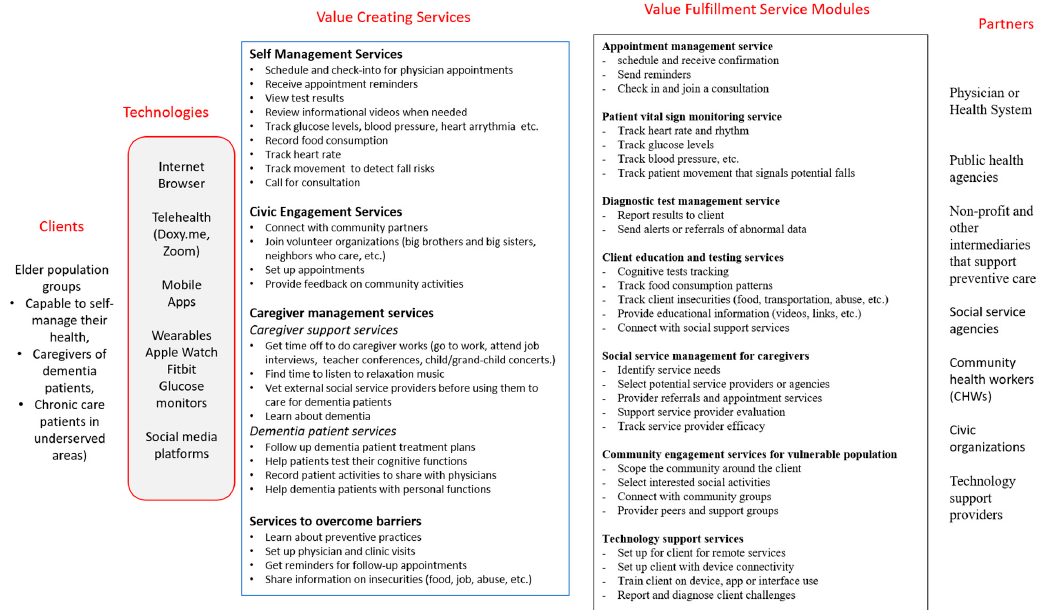
Figure 2. Digital platform to support digital service configuration.